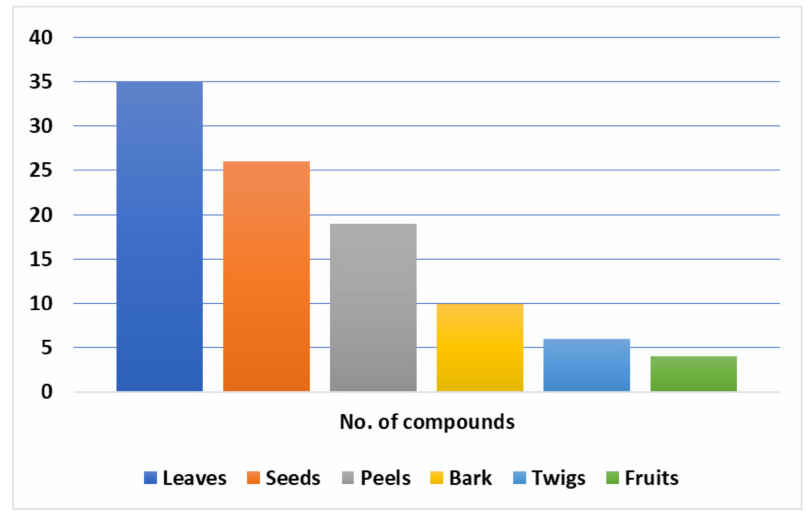
Figure 13. Number of metabolites reported from different part of Lansium domesticum . Most of the reported metabolites have been evaluated for their anticancer, antifeedant, insecticidal, antidiabetic, antimalarial, antimutagenic, and antibacterial abilities (Figure 14). It is noteworthy that 94 and 95 showed potent notch inhibitory potential; therefore, they may be a candidate for anticancer or neural regenerative agents. Further, 38 and 73 had potent antimalarial effectiveness that could be further investigated for their possible use as antimalarial agents.